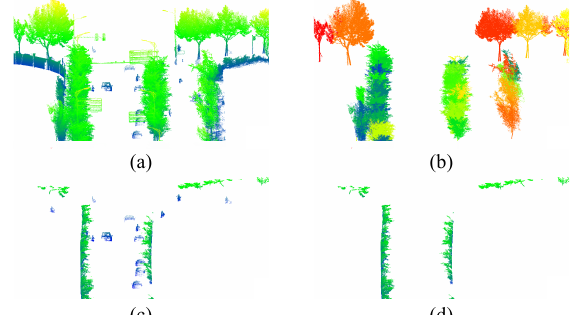
Figure 4 . General overview of street obstruction analysis: (a) Non-ground objects, (b) Street tree extraction, (c) Obstruction detection, (d) Obstruction